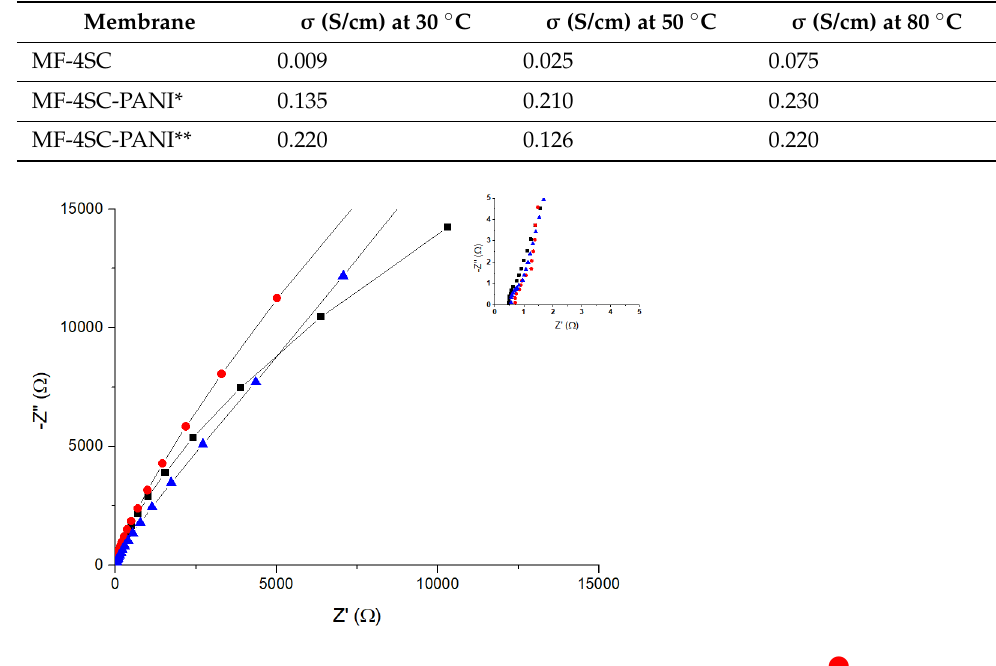
Figure 8. Nyquist diagram obtained for the samples MF-4SC ( (cid:4) ), MF-4SC-PANI*